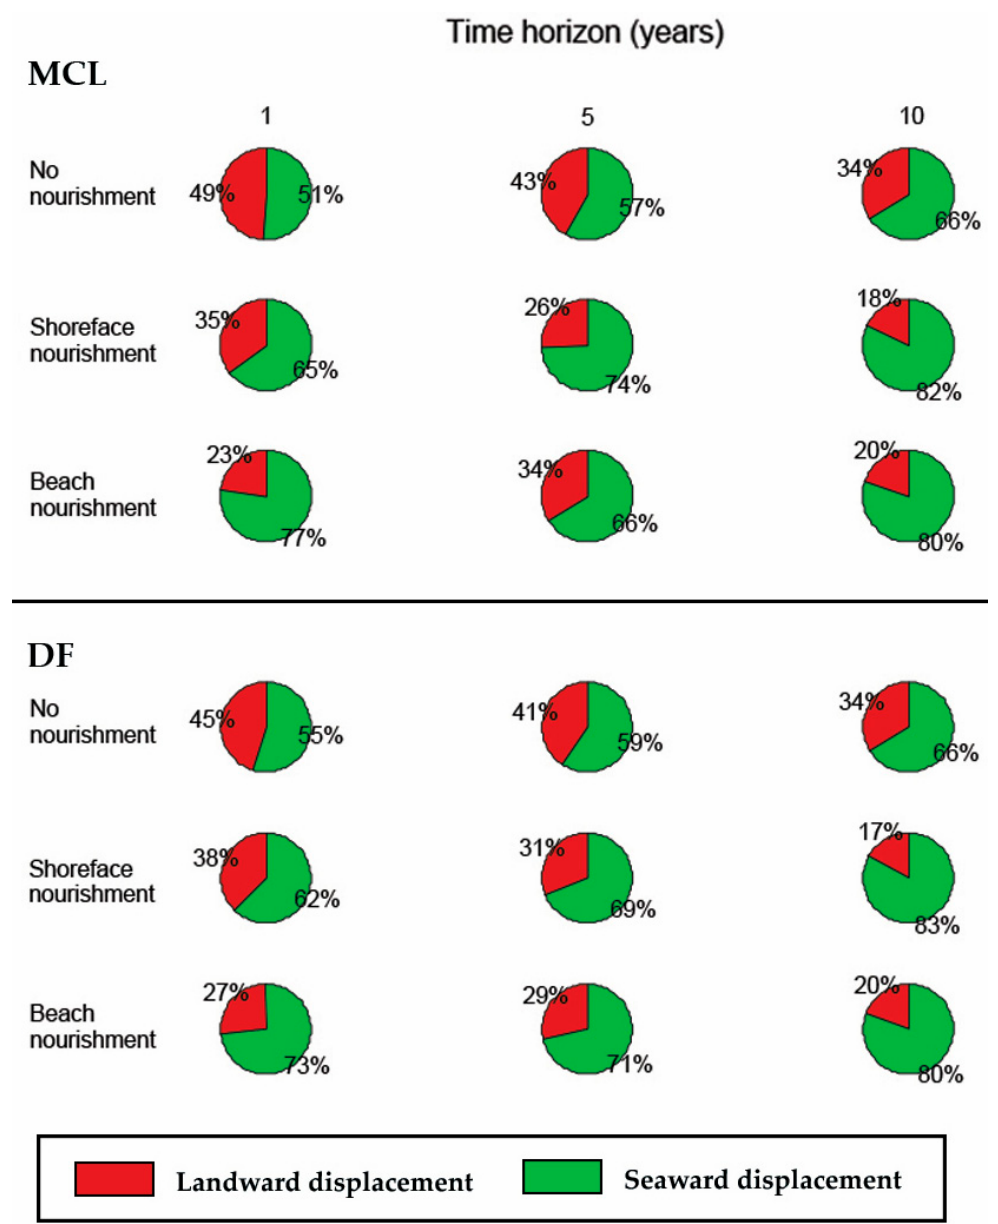
Figure 8. Effects of no nourishments, shoreface, and beach nourishments on MCL ( upper panel ) and DF ( lower panel ) indicators. The effects are shown in three different columns, to indicate the effects one year, five years and ten years after implementation of a nourishment.